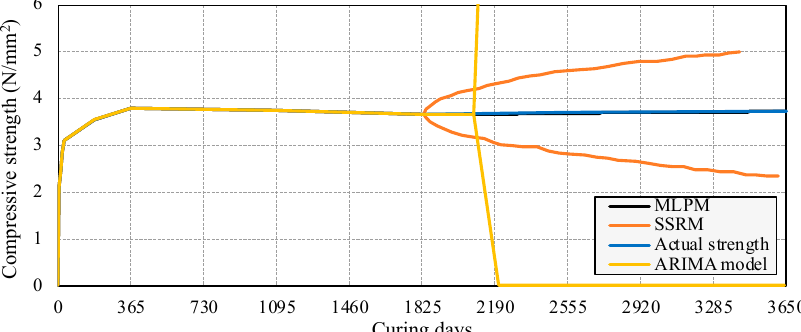
Figure 11. Comparison of the three models for the 5 ‐ year input data.